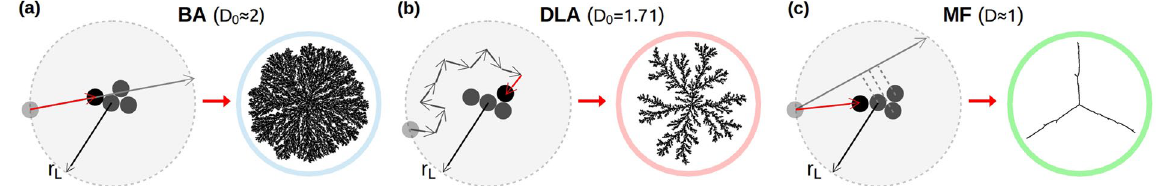
Figure 1. Fundamental aggregation models. After being launched into the system from r L with uniform probability, particles ( a ) follow straight-line trajectories before aggregation in BA, ( b ) perform a random walk in DLA, and ( c ) get radially attached to the closest particle in the cluster as a result of an infinite-range radial interaction in MF aggregation. The last one is particle-path independent and its morphological characteristics emerge solely from this long-range interaction as opposed to the stochastic BA and DLA models. Characteristic clusters for each model with their respective fractal dimension are shown.